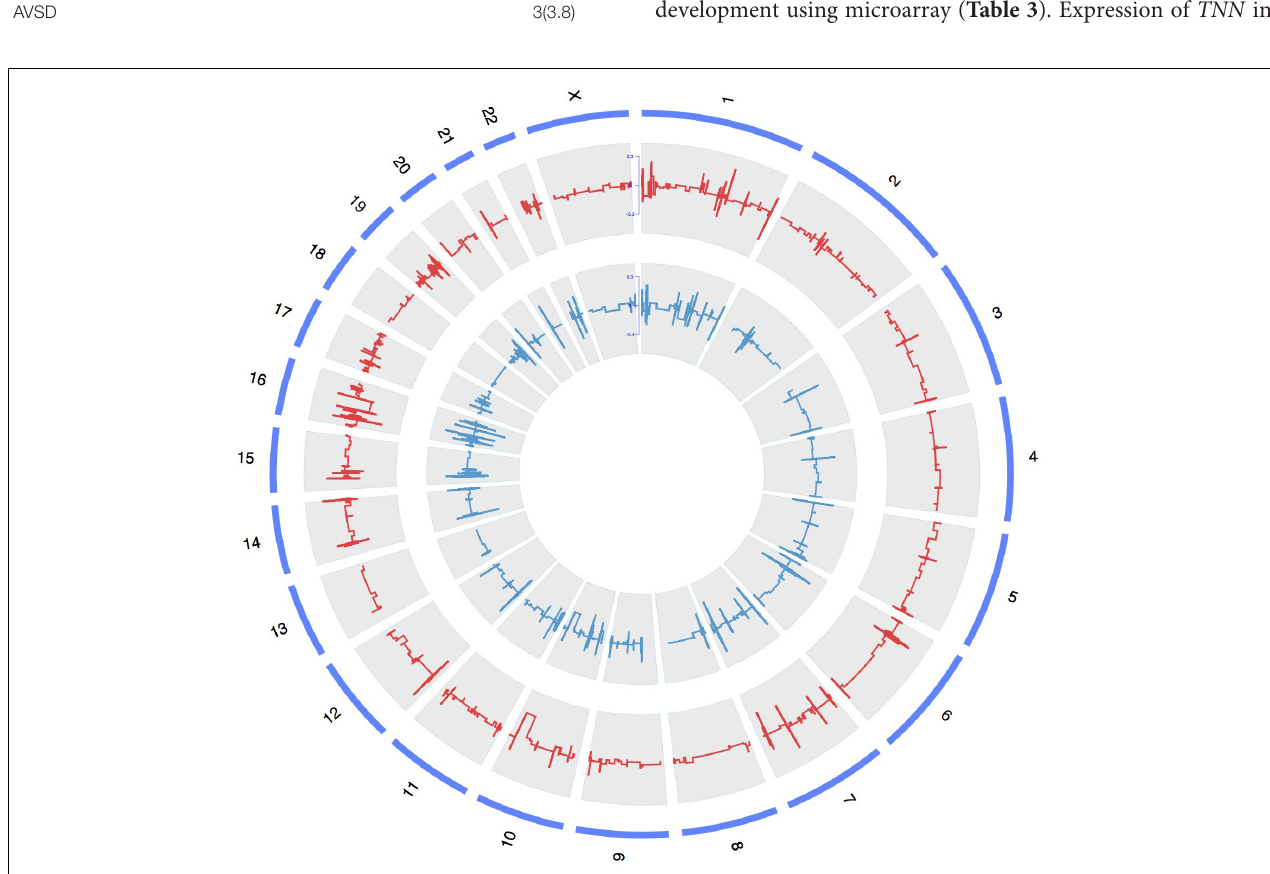
FIGURE 1 | A whole-genome view of copy number variations in case and control groups. Circos plot for variants visualization with broad horizontal area from chromosome level. The outer, middle, and inner tracks display the chromosomes, CNV frequency in case group, and CNV frequency in control group. The lines above or under zero represent gain or